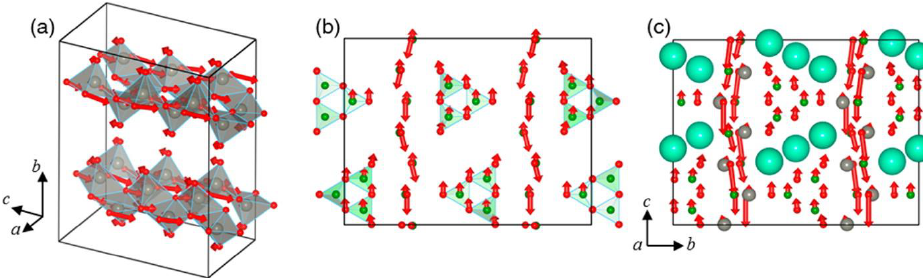
Figure 9. Atomic distortion patterns obtained from the symmetry-mode analysis: Oxygen atom displacements belonging to ( a ) the [ZnO 4 ] 6 − tetrahedra, ( b ) the [BO 3 ] 3 − network, and ( c ) the complete distortion projected along the a -axis. Reprinted (adapted) with permission from Ref. [45], Copyright (2014) American Chemical Society.